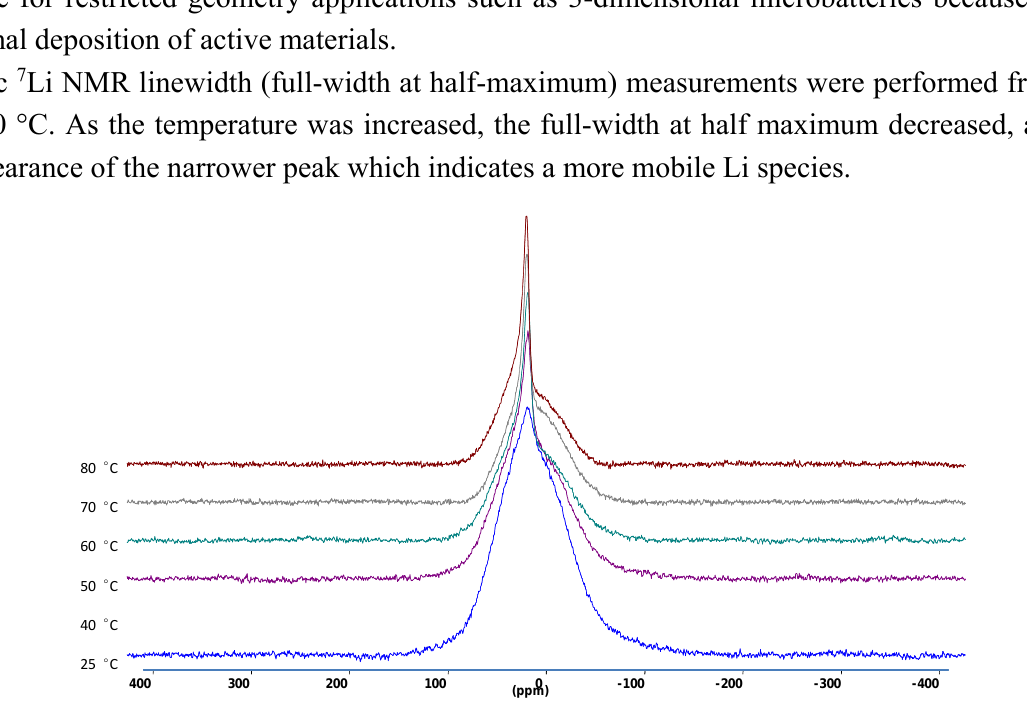
Figure 4. The 7 Li NMR spectra at different temperatures of 30 wt. % LiAlO 2 in PEO 2 LiI composite